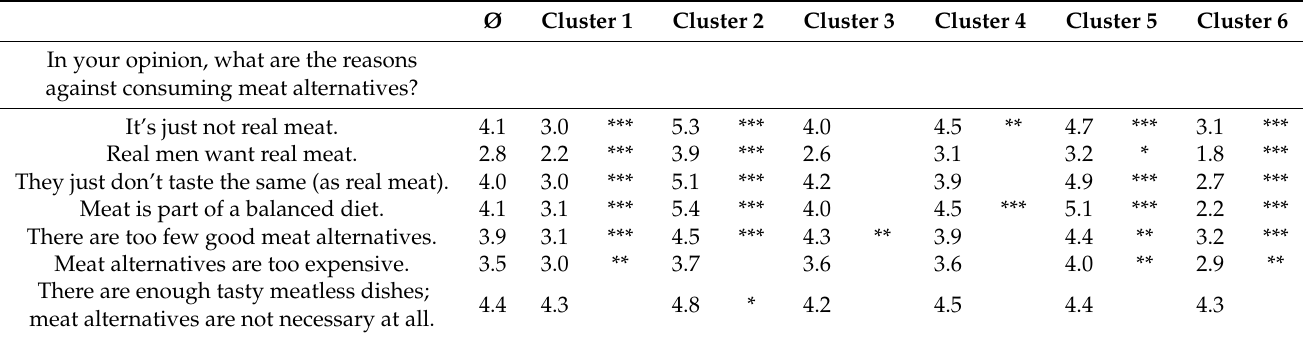
Table 7. Comparison of clusters with regard to respondents’ agreement with arguments against consuming meat alternatives.